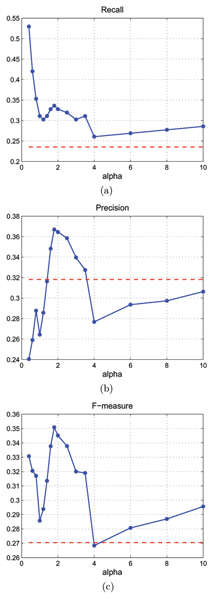
Comparison of the inferred connections and true relationships between the analyzed variables. Plots of recall (a), precision (b) and F-measures (c) of the nonlinear models as a function of the parameter α of the hyperbolic tangent function (continuous blue curves). The dashed red curves refer to the recall, precision and F-measure of the linear regression model. Further analyses showed that, for α → + ∞, recall saturates at 0.27, precision at 0.26, and the F-measure at 0.26.